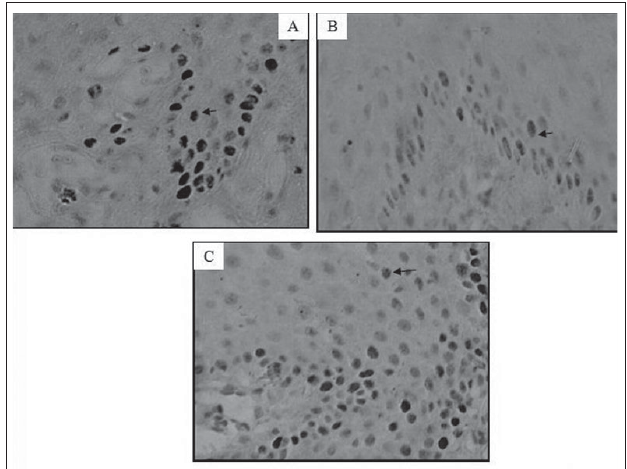
Fig. 9 IHC staining showing basal and suprabasal position of p53 positive cells (marked by arrows) in hyperplasia (A) and mild dysplasia (B), and spinous position in severe dysplasia (C) in different layers of oral epithelium.